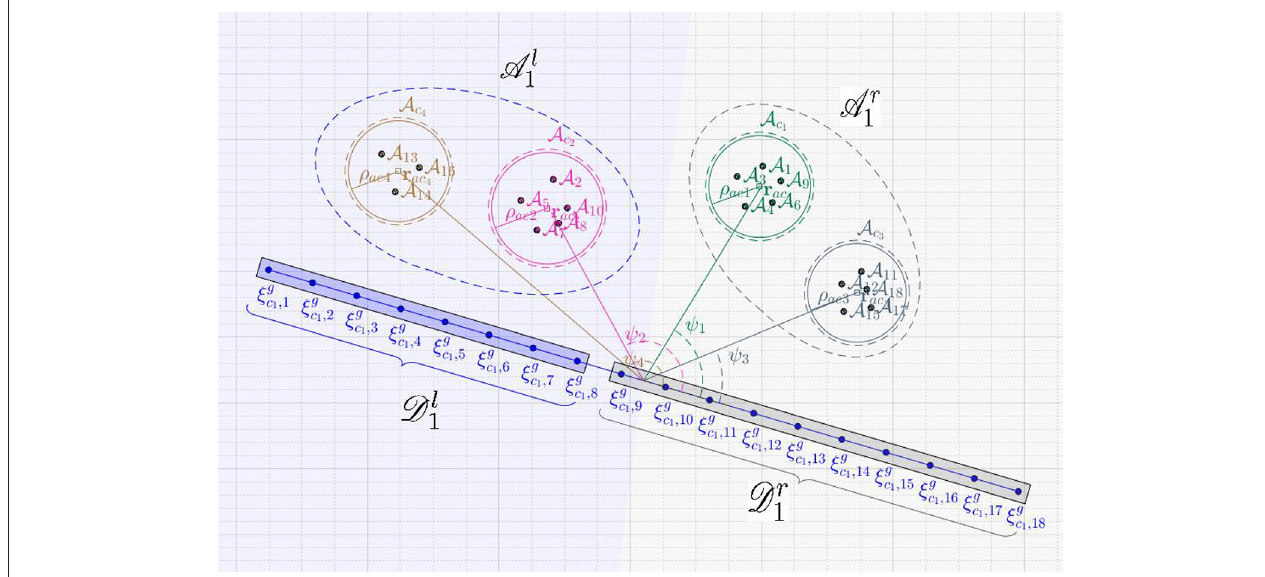
FIGURE 5 | Splitting for the hierarchical algorithm.